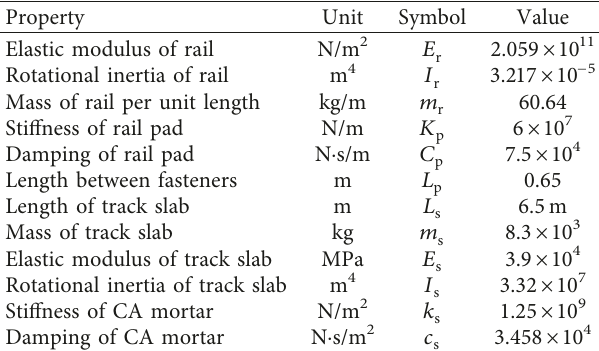
Table 2: Properties for high-speed